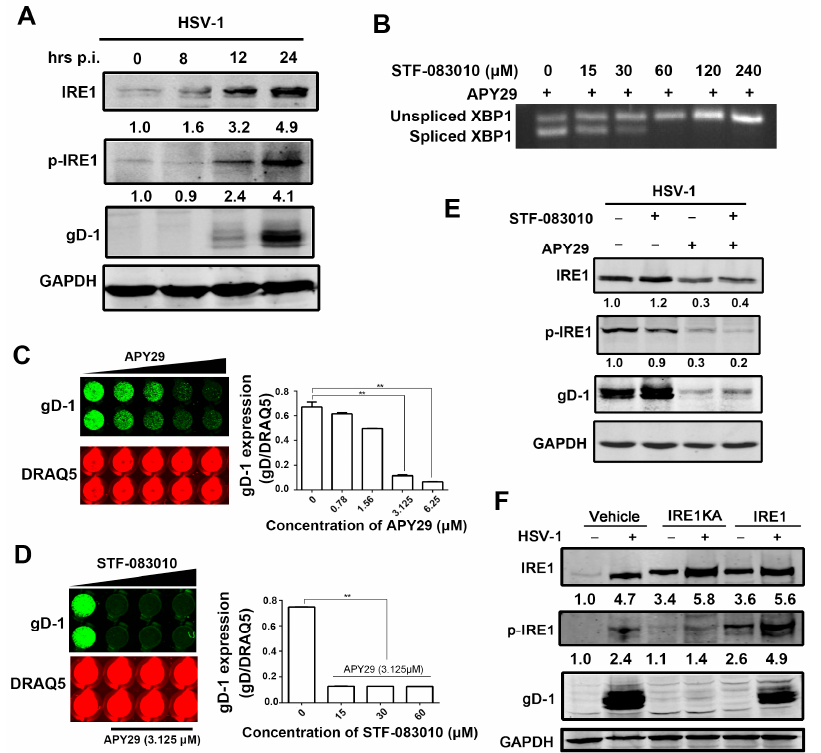
Figure 3. HSV-1 replication is regulated by kinase activity of IRE1 α . ( A ) HSV-1 infection stimulated kinase activity of IRE1 α in HEC-1-A cells. HEC-1-A cells were infected with HSV-1 (HF) (moi =